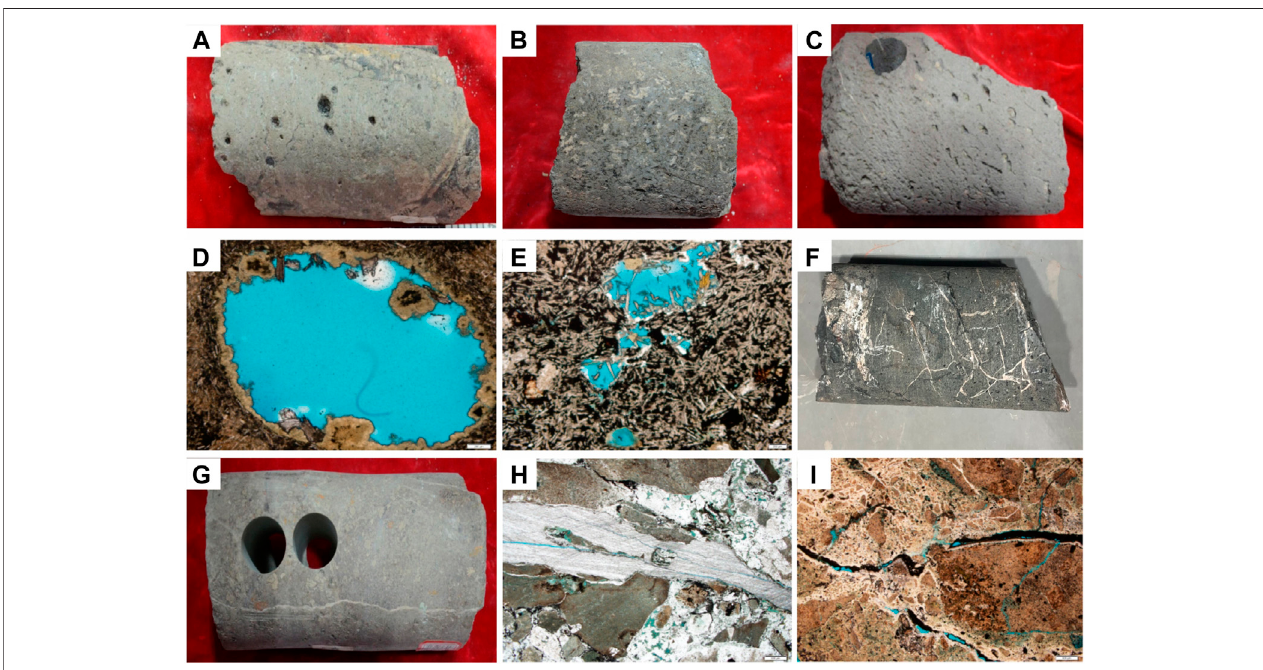
FIGURE 4 | Blowholes in upper subfacies of the lava and fractures in volcanic rocks. (A, B) Blowholes in andesite, SX16, 4805.5 m and SX4, 4822.4 m; (C) blowholes in basalt, SX4, 4720.2 m; (D) microscopic characteristics of blowholes in andesite, SX16, 4805.5 m; (E) microscopic characteristics of blowholes in basalt,